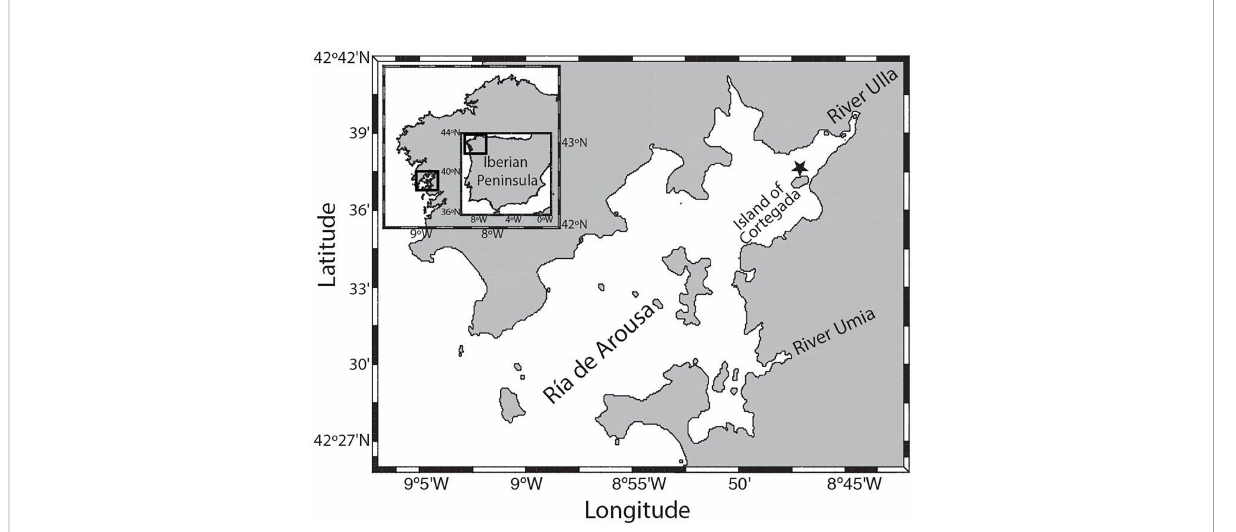
FIGURE 1 Geographical location of the SURCOM sensor deployment, CTD instruments and meteorological station (black star), at the Cortegada fl oating platform (42°37.54 ’ N; 8°47.03 ’ W), in the inner basin of R ı ́ a de